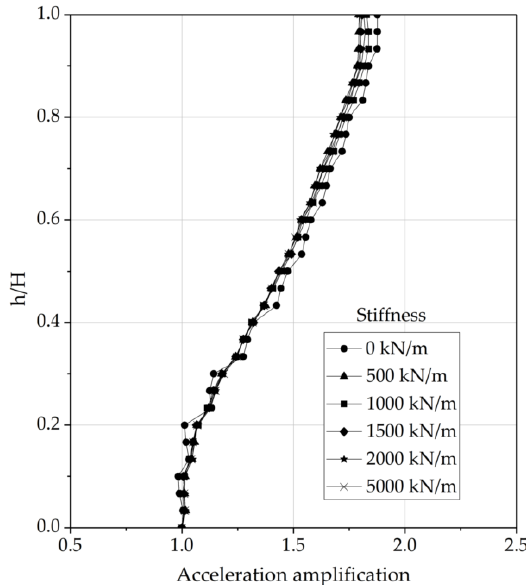
Figure 16. The variations of acceleration amplification out of the reinforced zone with different values of secondary reinforcement stiffness over the height of the backfill.